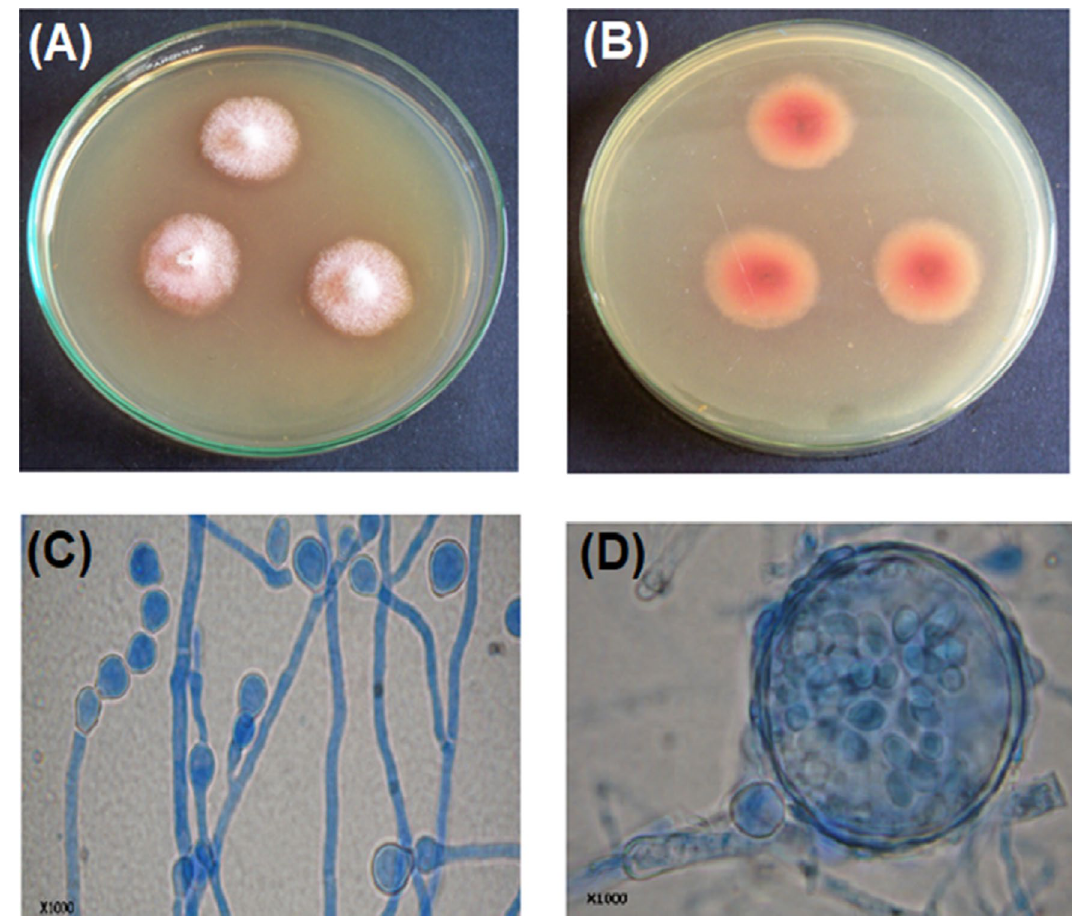
Figure 1. Morphological characteristics of the red pigments-producing fungal strain. Colony growth was observed on Czapek–Yeast autolystae agar. The plate cultures on the left show a front view of the growth ( A ), and the plate cultures on the right show a reverse view ( B ) of the growth after incubation for 10 days at 25 °C. Appearance under light microscope ( C , D